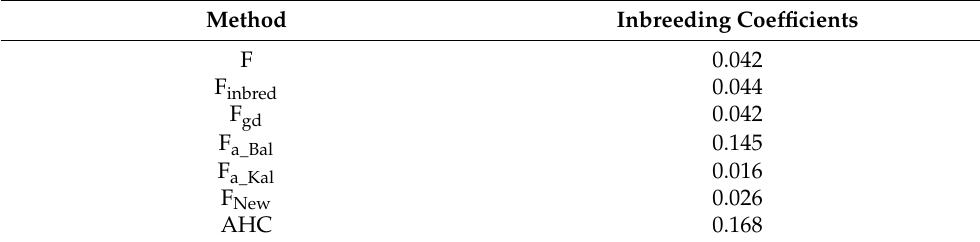
Table 3. Mean inbreeding coefficients according to Meuwissen and Luo for all animals (F) and inbred animals (F inbred ), individual inbreeding using the genedrop method (F gd ), ancestral inbreeding according to Ballou (F a_Bal ) and Kalinowski et al. (F a_Kal ), new inbreeding according to Kalinowski (F New ) and ancestral history coefficient according to Baumung et al. (AHC), for Deutsch Drahthaar dogs born from 2000 to 2020.